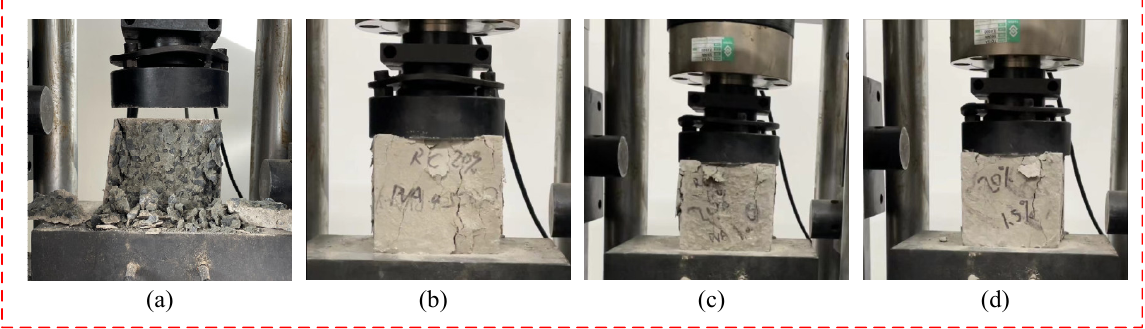
Figure 4. Failure modes in cubic compressive tests: ( a ) Plain concrete; ( b ) RC20%-PVA0.5%; ( c ) RC20%-PVA1.0%; ( d ) RC20%-PVA1.5%.